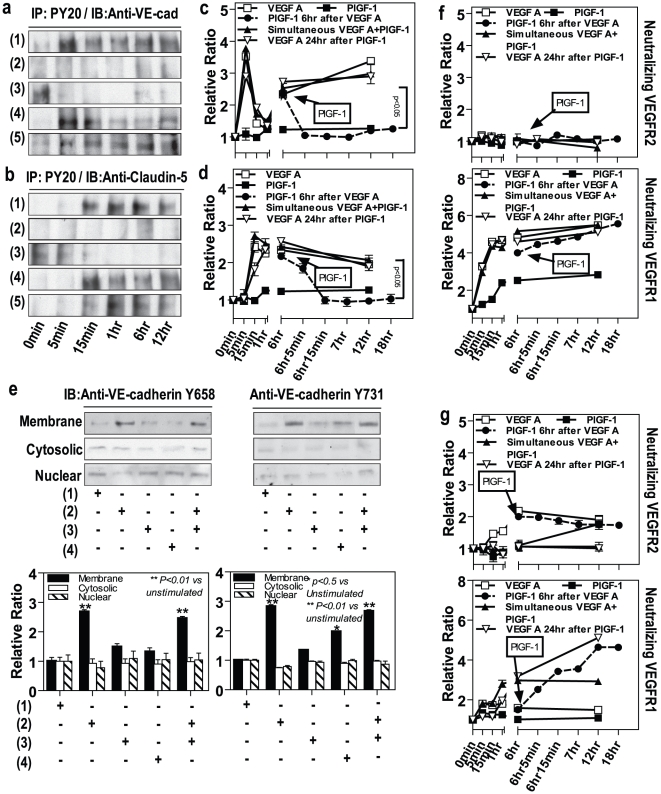
PlGF-1 reverses VEGF-induced phosphorylation of VE-cadherin followed by claudin-5.Representative immunoblots showing time-dependent phosphorylation of VE-cadherin (a) and claudin-5 (b) following treatment of endothelial cells with VEGFA alone, hPlGF-1 alone, simultaneous VEGFA + hPlGF-1 and hPlGF-1 6 hours post VEGF for periods up to 12 hours (n = 4 independent experiments). VEGFA and hPlGF-1 were used at 100 ng/ml. Membrane fractions were immunoprecipitated with PY 20 and Western blot undertaken for VE-cadherin and Claudin-5. Laser densitometry quantification of immunoblots showing the relative ratio of VE-cadherin (c) and claudin-5 (d) phosphorylation to the heavy chain of PY20 (n = 4 independent experiments). (e) Representative immunoblots and laser densitometry showing the effect of the treatments in (a) on the phosphorylation status of VE-cadherin Y658 and Y731 (n = 4 independent experiments). (1) = VEGFA; (2) = PlGF-1; (3) = PlGF-1 6 hr after VEGFA; (4) = simultaneous VEGFA + PlGF-1 and (5) = VEGF A 24 hr after PlGF-1. (f) & (g) The effect of neutralizing antibodies to VEGFR1 or VEGFR2 (2 µg/ml) on the phosphorylation of VE-cadherin and Claudin-5 treated as described in (a). Data are represented as means ± s.e.m. *p<0.05, ** by p<0.01 (Mann-Whitney U test).